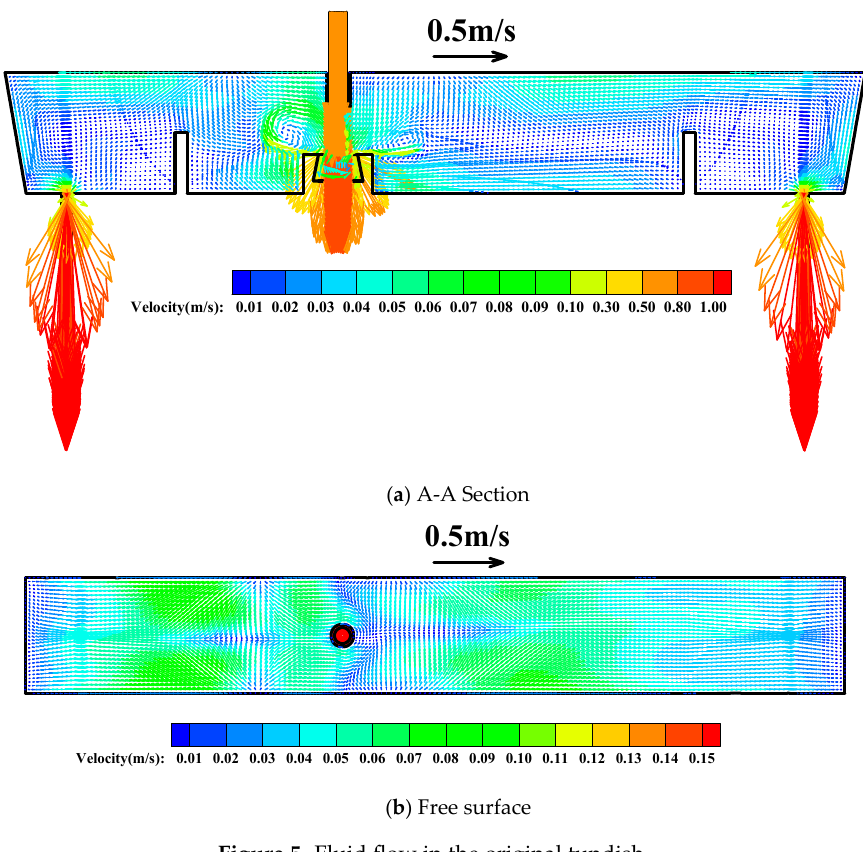
Figure 5. Fluid flow in the original tundish.